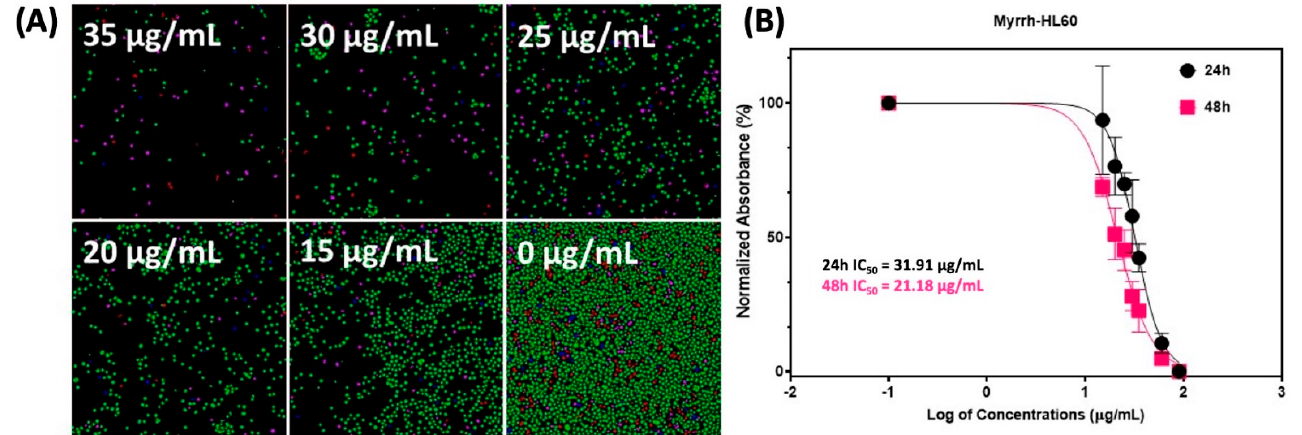
Figure 3. Treatment of leukemic HL60 cell line with myrrh extract. ( A ) High content imaging of treated cells at 48 h. The cell health module was used to identify live (green), pre-apoptotic (blue), post-apoptotic (pink), and dead (red) cells. ( B ) Cell viability was assessed by TiterGlo™ assay at 24 h and 48 h. Five points, i.e., 35, 30, 25, 20, and 15 µ g/mL serial dilution, were used to calculate the IC 50 values (shown in the figure). The X -axis presents the log of myrrh concentration in µ g/mL, and the Y -axis represents the percentage cell viability.